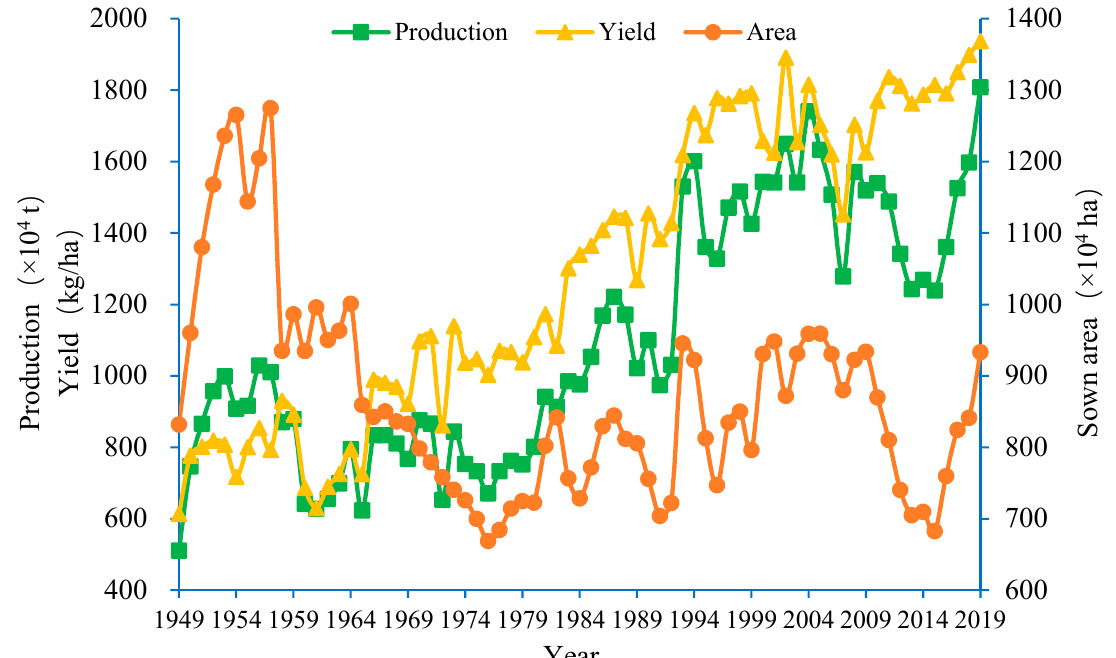
Figure 2. Changes in the soybean sown area, production, and yield in China from 1949 to 2019.